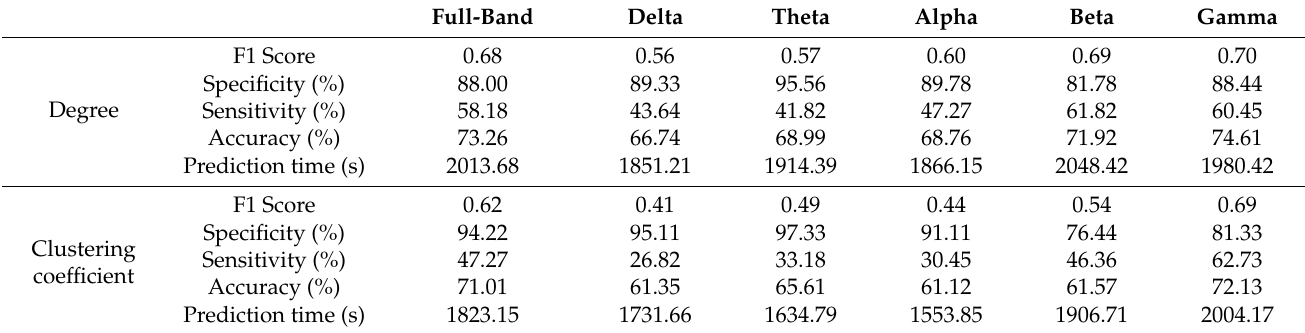
Table 3. This table shows the prediction results of degree and clustering